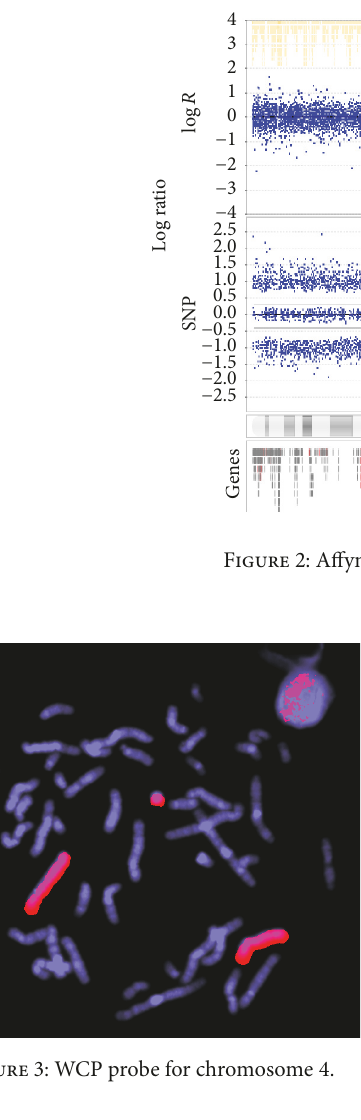
FISH analysis was instigated to confirm the origin of the ring chromosome. Whole chromosome paints demonstrated that the ring originated from chromosome 4 (Figure 3).